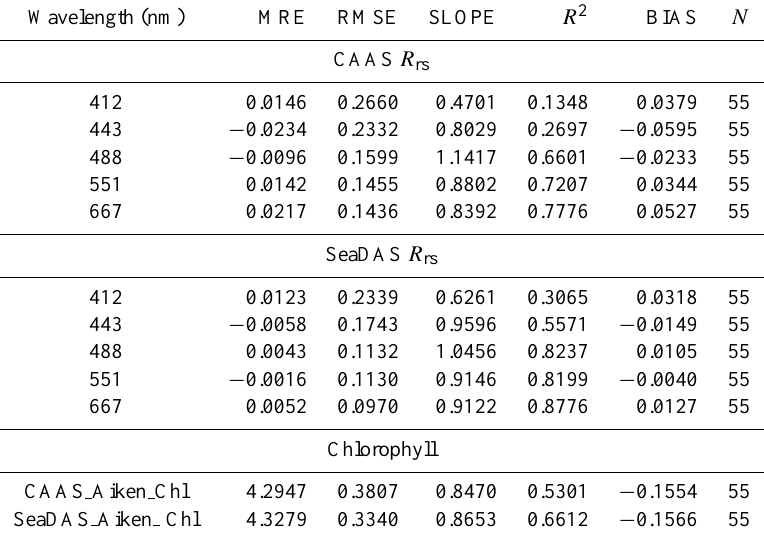
Table 1. Comparison of algorithm performances using MODIS-Aqua R rs (from SeaDAS and CAAS algorithms) and coincidently measured (in situ) R rs (NOMAD data sets). Note that the in-situ measurements are made at 412, 443, 490, 555 and